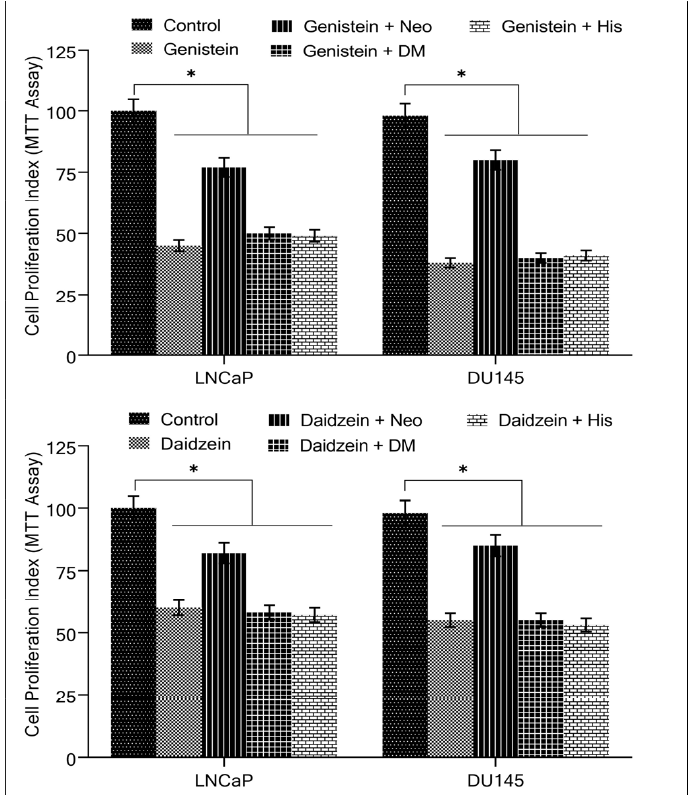
Figure 4. The effect of different metal chelators on the antiproliferative effects of genistein and daidzein in prostate cancer cell lines. As indicated in the figure, LNCaP and DU145 cancer cells were treated with 50 µ M genistein/and daidzein either alone or in the presence of copper chelator neocuproine (Neo), iron chelator desferrioxamine mesylate (DM) or zinc chelator histidine (His). Metal chelators were utilized at a concentration of 50 µ M. The MTT assay was done 96 h following treatment, as stated in Section 4. Values reported are mean ± S.E of three independent experiments. * p value < 0.01 when compared to